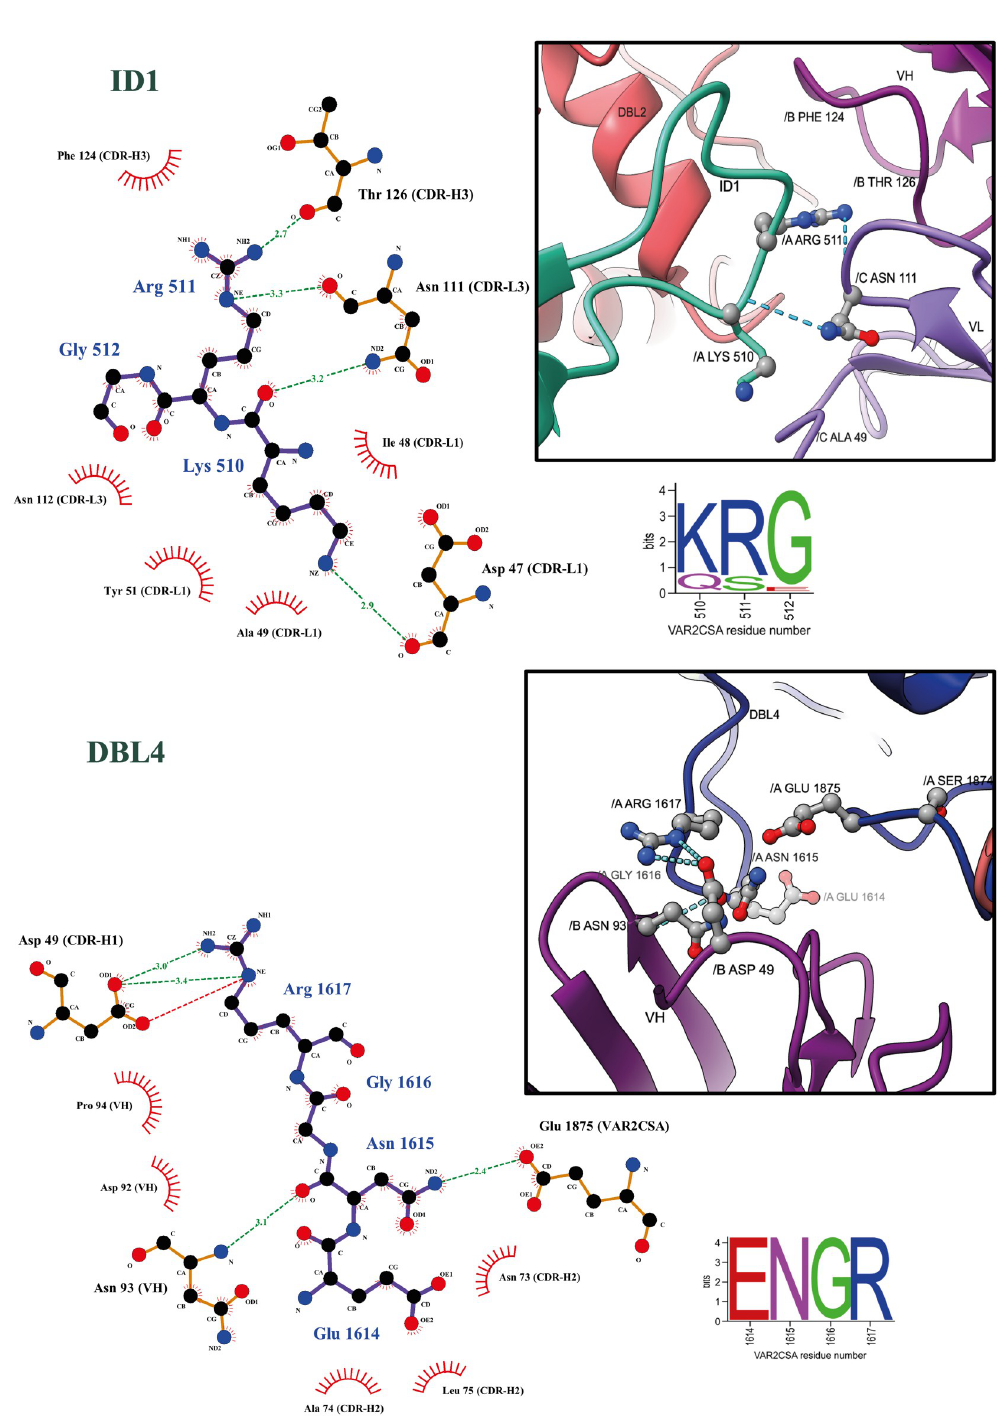
Fig 4. PAM1.4 Fab interaction analysis to ID1 and DBL4. Binding plot analysis using Ligplot+ v.2.7. Hydrogen bonds are shown in green dotted lines, electrostatic interactions in red dotted lines and hydrophobic contacts are shown as short spokes radiating from each atom or residue. Sequence conservation of PAM1.4-interacting amino acids in FCR3 VAR2CSA is shown in sequence LOGOs extracted from a previously published sequence alignment LOGO of 3737 VAR2CSA variants found in [13]. FCR3 VAR2CSA sequence positions 510 and 1614 correspond to alignment positions 523 and 1760 respectively. Representation of corresponding Ligplot+ in UCSFChimeraX showing ID1 and DBL4 interactions to Heavy and light chain CDRs of PAM1.4 Fab. Hydrogen bonds are represented in dotted blue lines. Non-CDR residue N93 of heavy chain is shown to form hydrogen bond with N1615 of DBL4 domain in VAR2CSA.